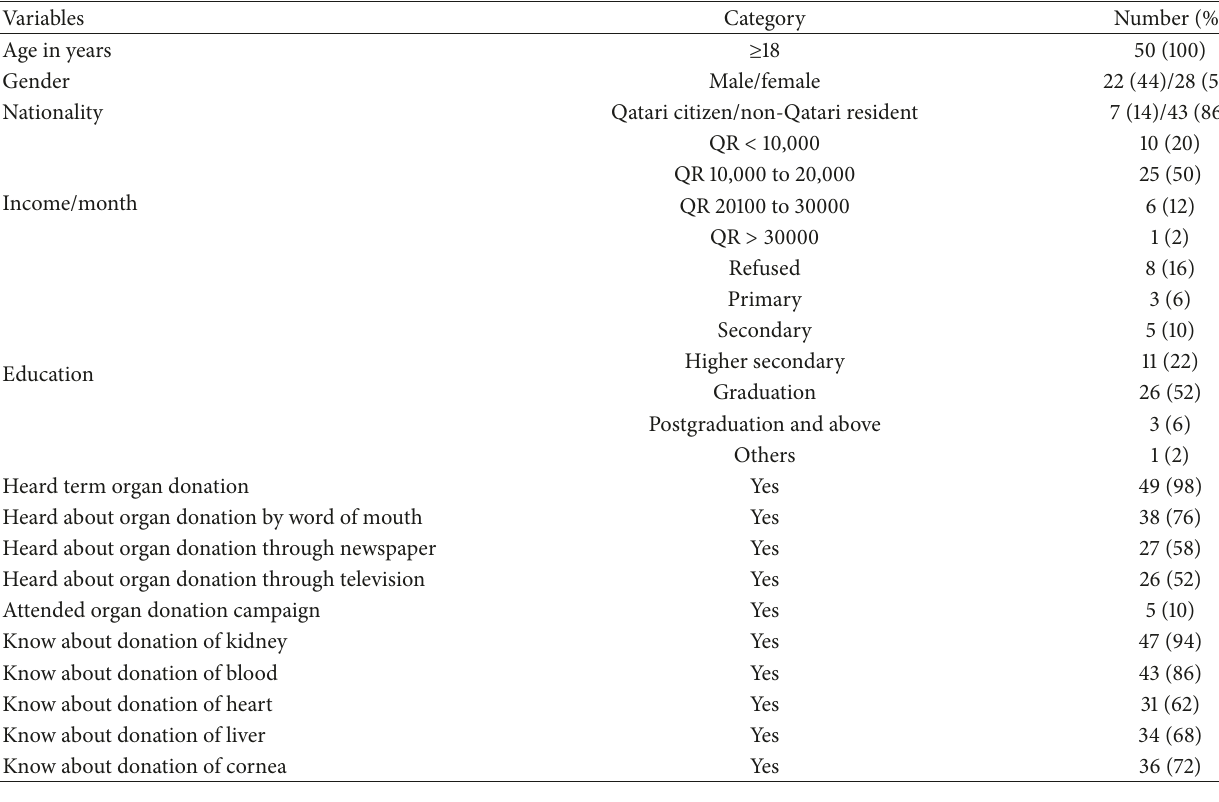
Table 1: Demographic and general characteristics.